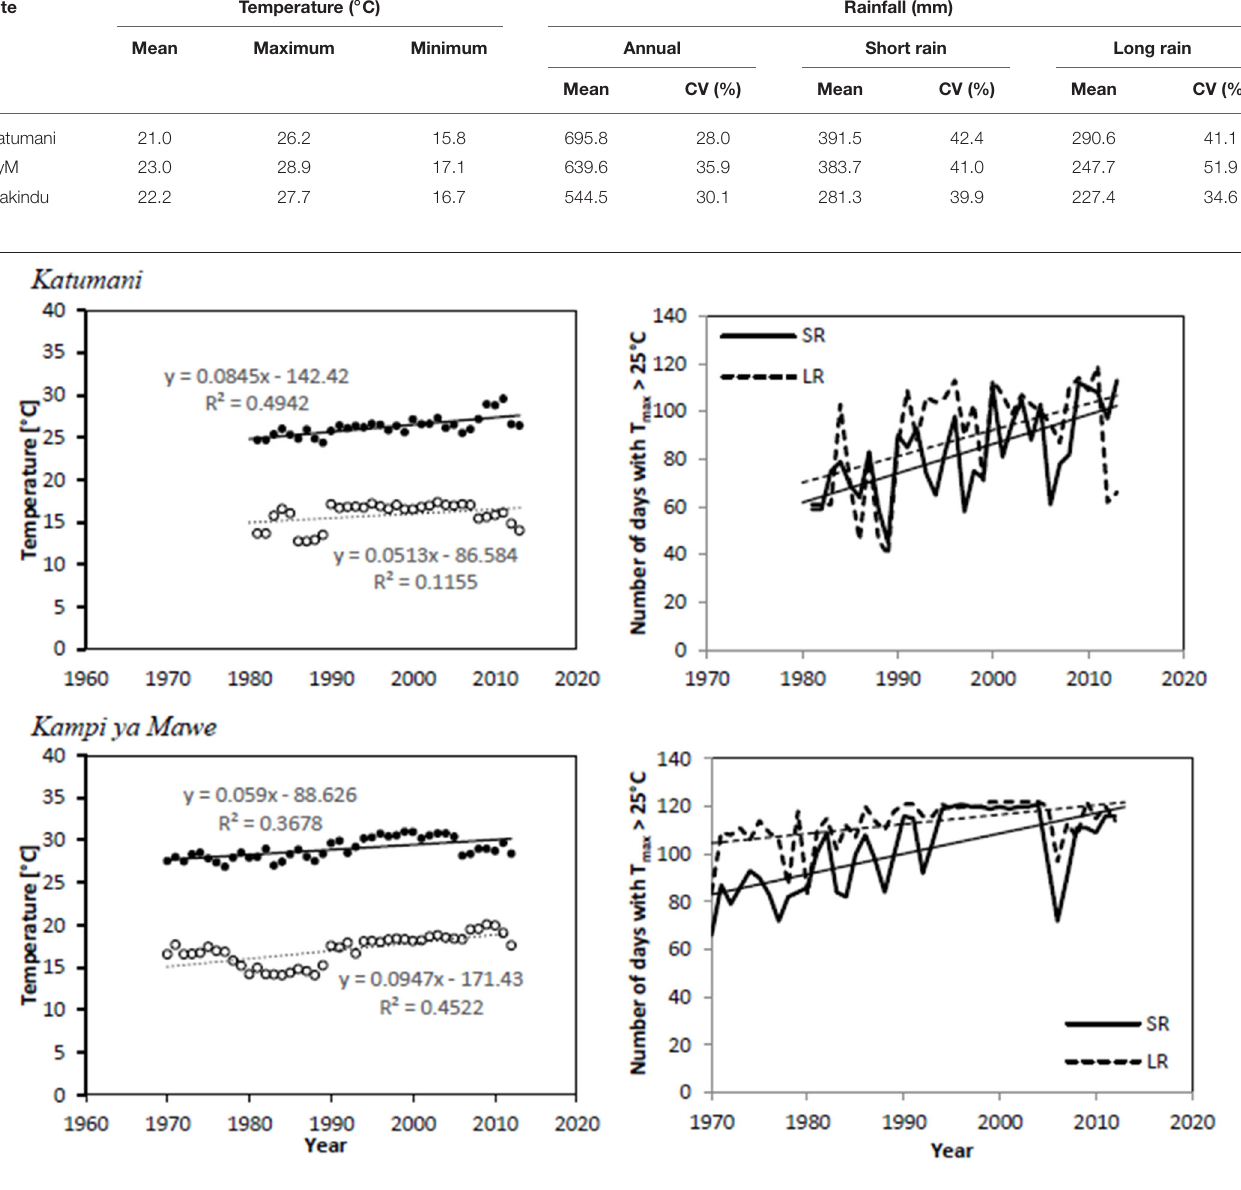
FIGURE 1 | Time series and trends for minimum ( ◦ ) and maximum ( • ) temperatures as well as number of days with maximum temperatures > 25 ◦ C for the growing period of the short rain (SR,—) and long rain (LR, −−− ) at Katumani and Kampi ya Mawe, Eastern